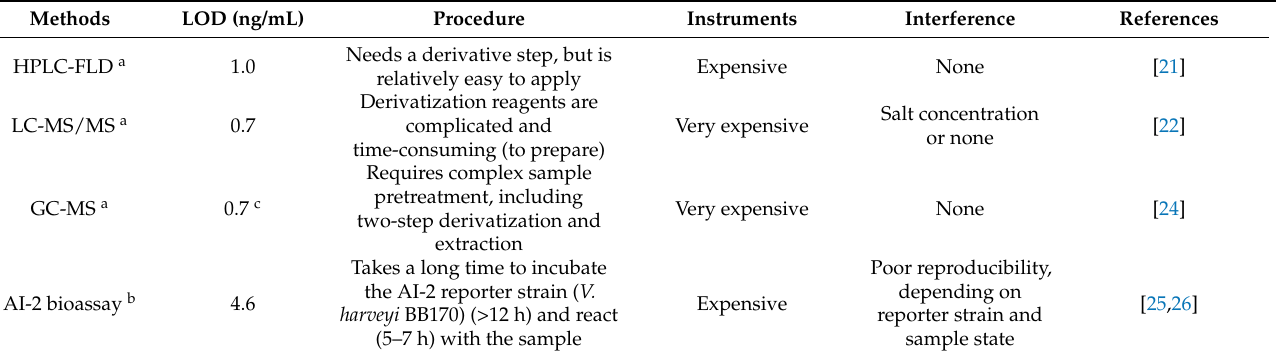
Table 1. Methods of AI-2 detection reported in the